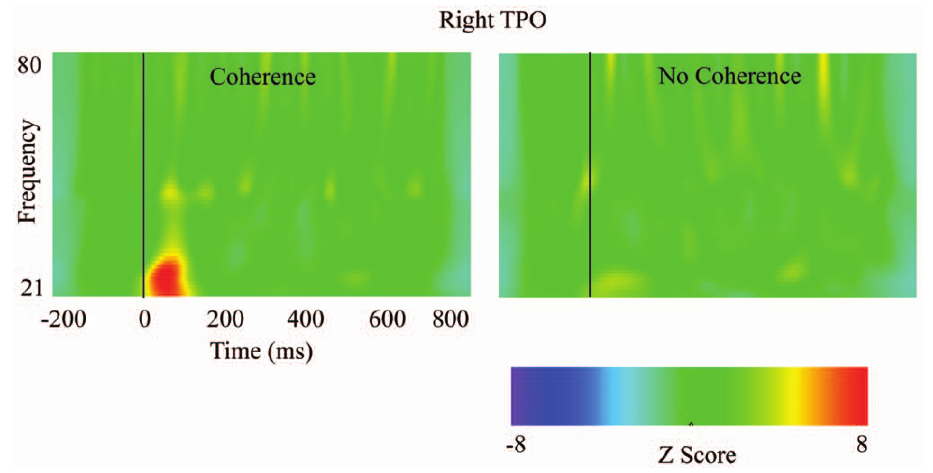
Figure 6. Time-Frequency plots of evoked oscillatory activity between 21–80 Hz. Energy increases and decreases after stimulus onset (time 0) are defined as standard deviations from the baseline period ( 2 200–0